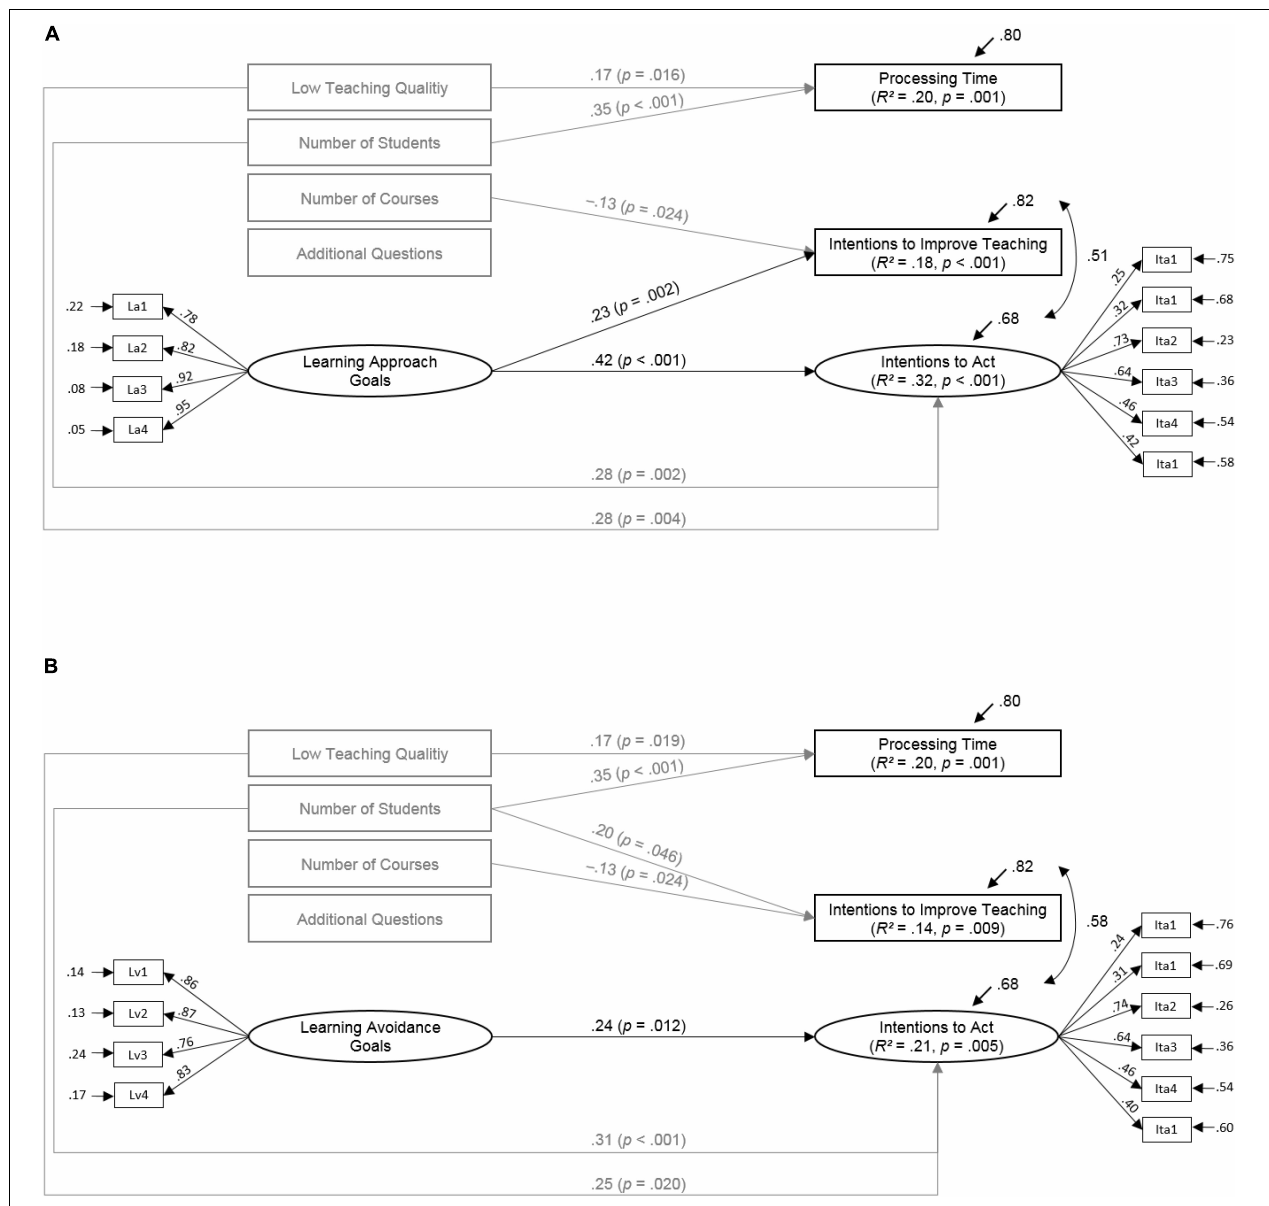
FIGURE 2 | Results of the mediation models for the associations between learning approach/avoidance goals and intentions to act on SET-results and improve teaching via processing time ( N = 152). Only statistically significant paths are depicted ( p < 0.05). One-tailed significance levels are reported for directed hypotheses (depicted in black); two-tailed levels of significant are reported for the associations with control variables (depicted in gray). The correlations between the predictor variables varied between –0.36 and 0.74 in Model (A) and between –0.10 and.25 in Model (B)